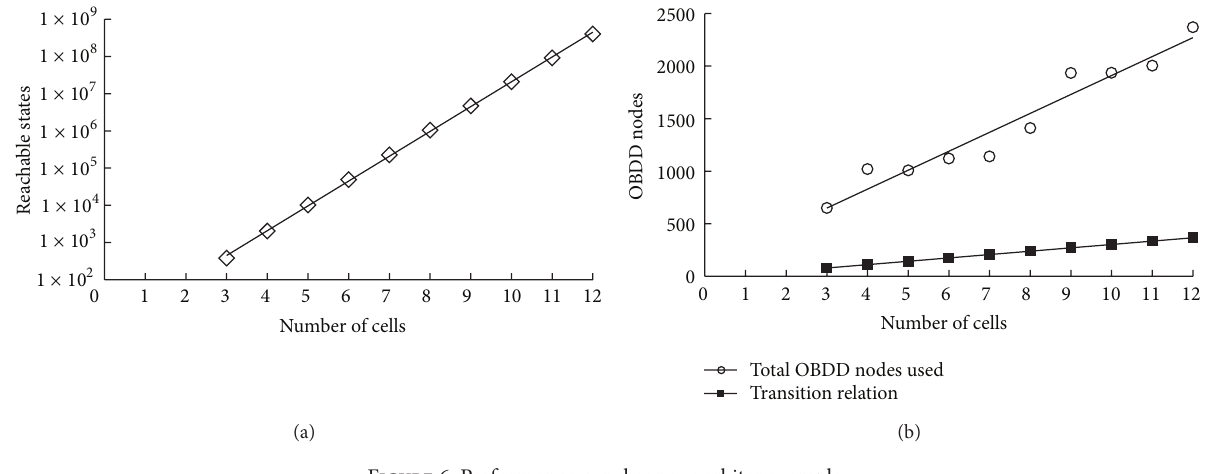
Figure 6: Performance-synchronous arbiter